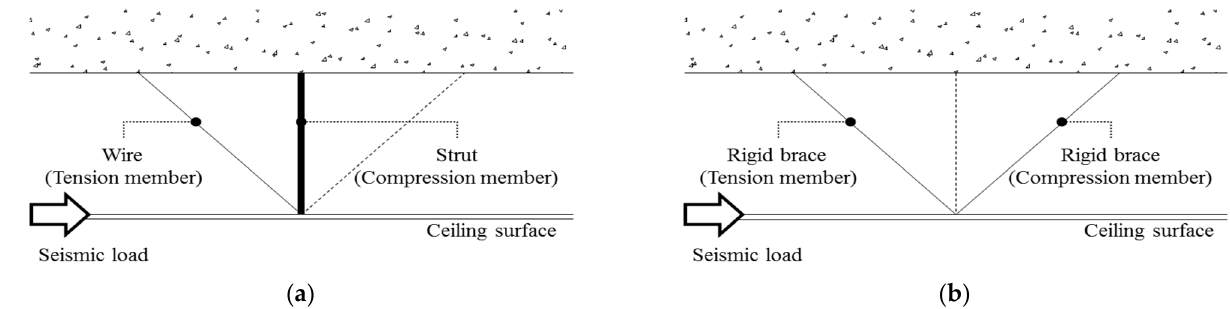
Figure 2. Types of brace systems: ( a ) strut–tie brace system; ( b ) rigid brace system. (Dotted line: zeroforce member).